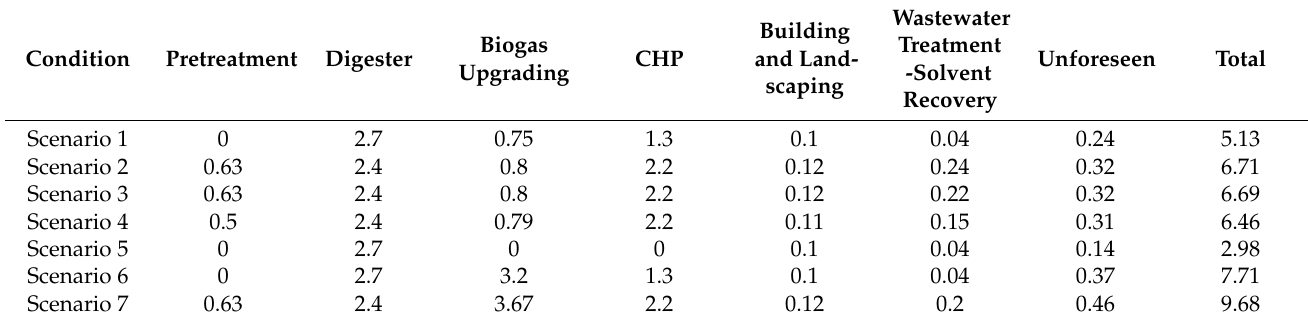
Table 12. Fixed Investment costs (million USD).